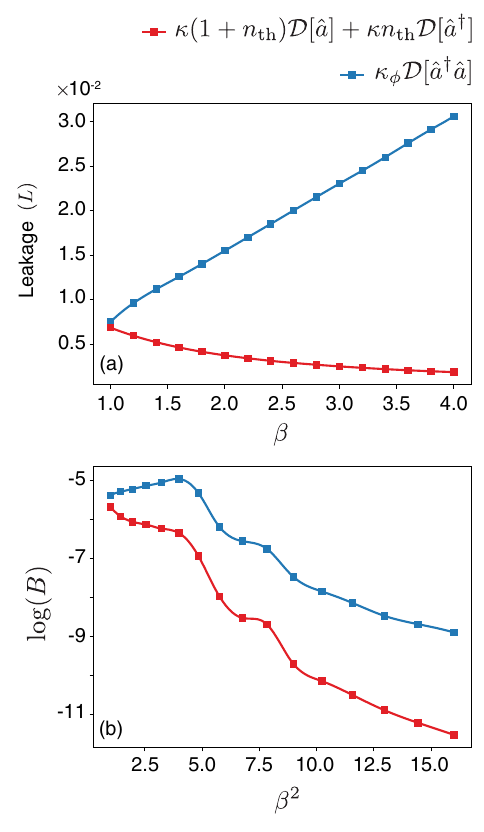
FIG. 4. The figure shows the leakage errors [ ε l in Eq. (18)] in the PCO and the corresponding backaction [ ε in Eq. (19)] on the b encoded qubits due to white thermal noise (red squares) and pure dephasing (blue squares). The squares are the results of simulat- _ ˆ ρ ˆ H; ˆ ρ ing the master equation (i) ¼ − i ½ (cid:2) þ κ ð 1 þ n th Þ D ½ ˆ a (cid:2)þ D ½ ˆ a † (cid:2) and (ii) _ ˆ ρ ¼ − i ½ ˆ H; ˆ ρ (cid:2) þ κ D ½ ˆ a † ˆ a (cid:2) . ˆ H is given in κ n ϕ th Eq. (15), and the solid lines are merely spline interpolations. 10% , κ ¼ K= 200 , κ 2000 , and P is varied between n ϕ ¼ K= th ¼ K and 16 K . χ ¼ ð π = 2 Þ χ 0 sin ð π t=T , χ 0 ¼ K= 20 , and T z Þ z ¼ β ð p þ p − 1 Þ . The reduced density matrices ˆ ρ π = 4 χ and ˆ ρ 0 q PCO are evaluated at T . As expected from the simple analysis in z Secs. IV and V, the backaction on the qubits exponentially decreases as the size of the cat β in the PCO increases. In particular, log ð ε decreases (approximately) linearly with β 2 for b Þ larger β . This decrease agrees with the behavior expected from Secs. IV and